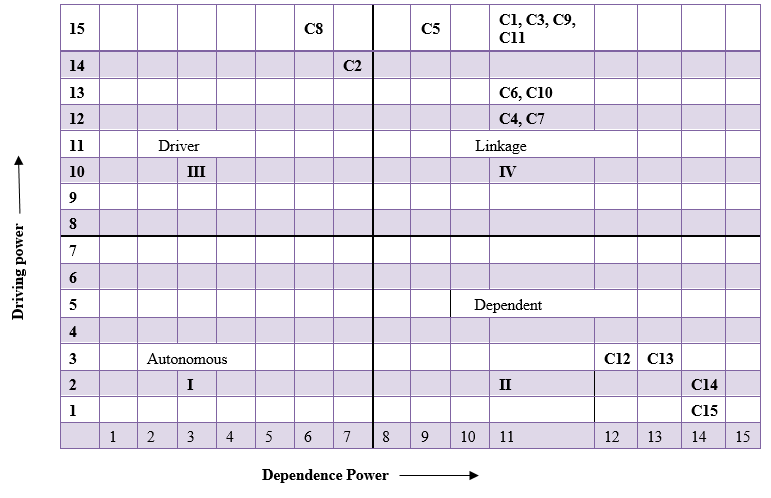
Figure 4. MICMAC analysis representation.